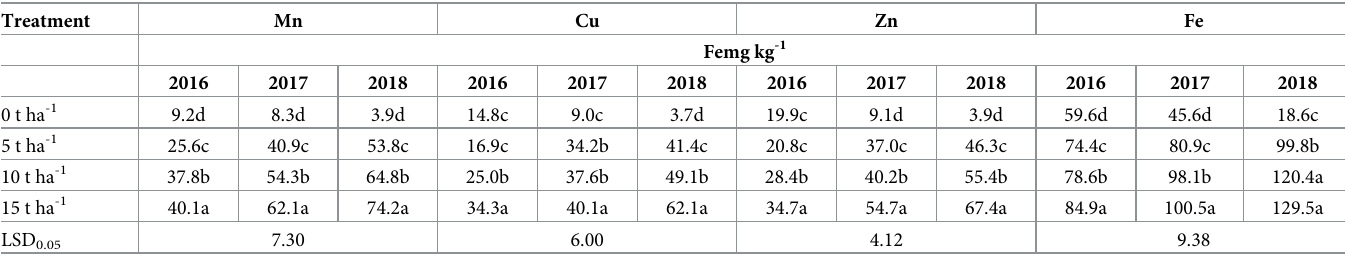
Table 12. Soil micronutrients (Mn, Cu, Zn and Fe) as influenced by compost application rates over a three year study (2016–2018) at the Politsi orchard.